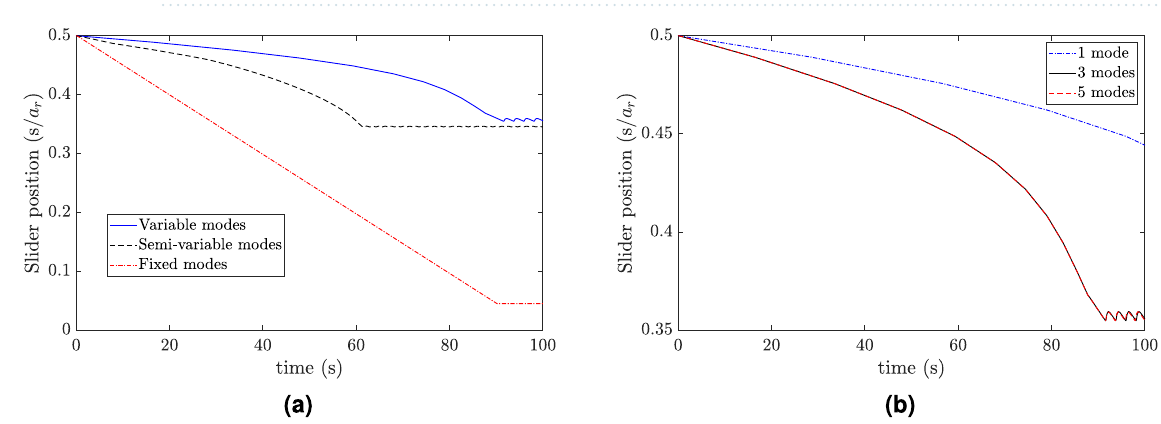
Figure 3. ( a ) The first mode of the combined structure at slider position s = 0.5 a r ; different systems’ portions highlighted in the supplementary material (i.e., w i are demonstrated in the legend in addition to the slider); however, the y-axis represents the structure displacement (i.e., w ); ( b ) comparison between the combined structure mode shapes and the resonator at different slider positions.